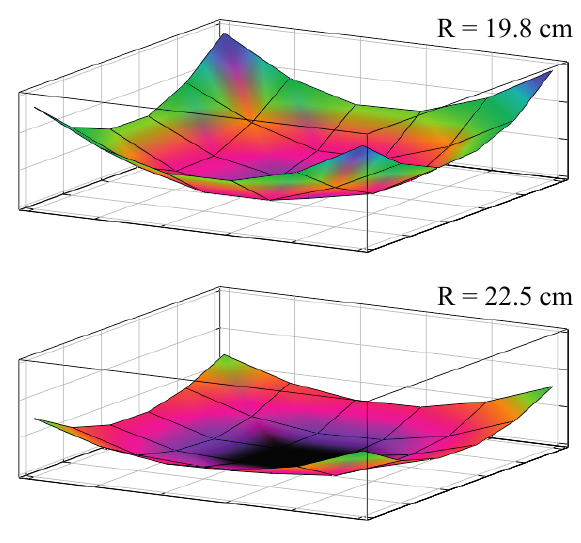
Figure 8. The traced profiles for styrofoam half balls with different